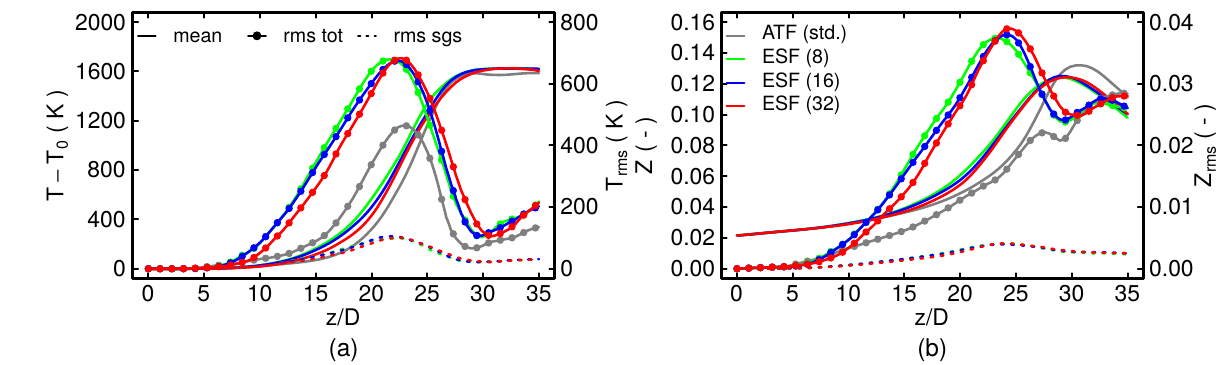
Figure 5. Axial evolution of temporal averages and rms of temperature ( a ) and mixture fraction ( b ) along the centerline. The dashed line corresponds to total rms while the dotted line represent the unresolved contributions obtained from the LES-ESF simulations.